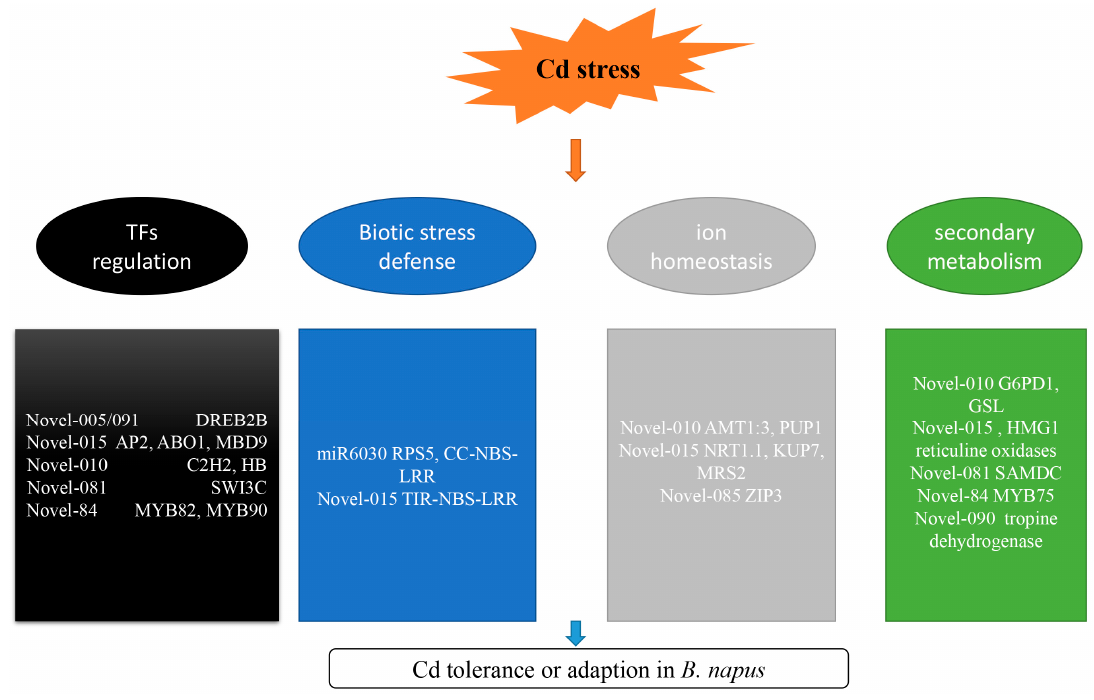
Figure 8. A hypothetical integrated schematic diagram of the mechanisms involved in Cd tolerance in Brassica napus .